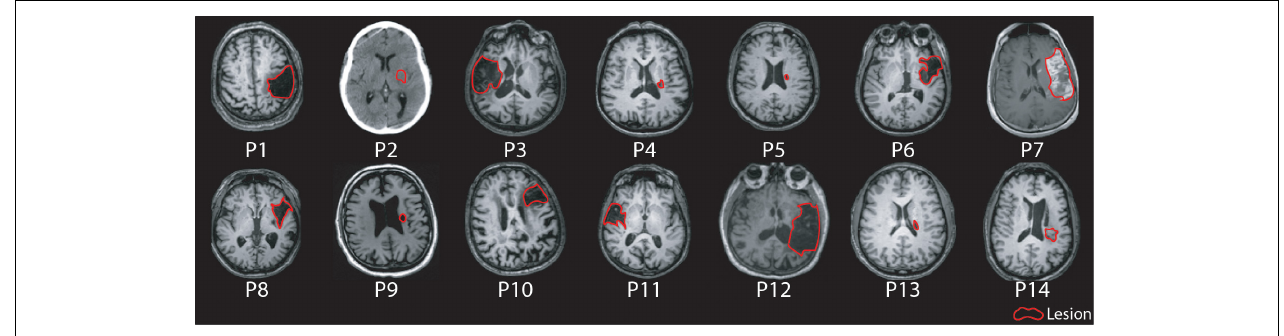
FIGURE 1 | Axial MR/CT images for individual patients illustrating the stroke lesion. Images are displayed in radiological convention. Images are labeled by participant number.